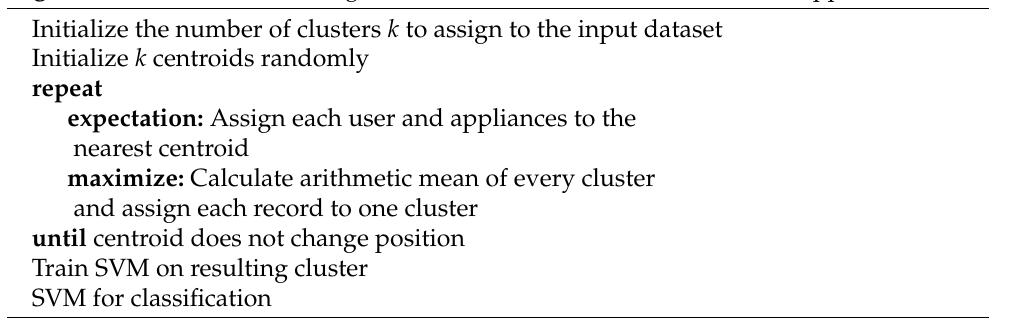
Algorithm 1 k-means clustering and SVM for classification of users and appliances